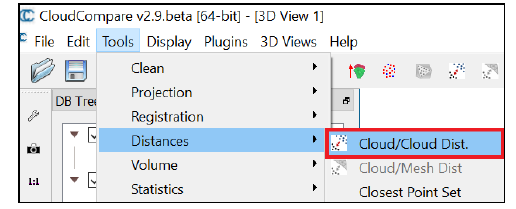
Figure 39. Cloud to cloud distance menu